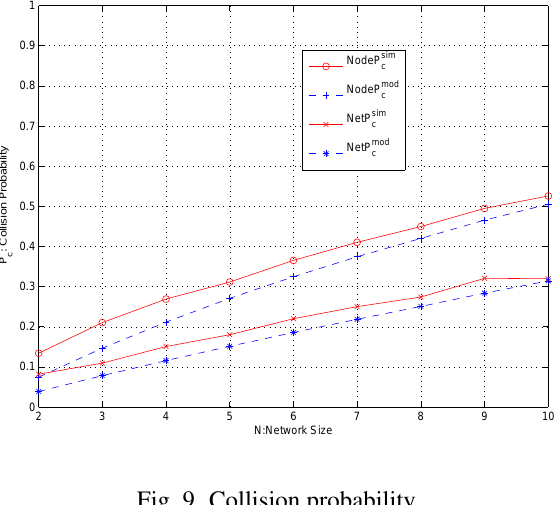
Fig. 9. Collision probability The power consumption is shown in Fig. 10. The simulation results well match the theoretic results. The interesting thing is that the average power con- sumption of the network is decreasing along with the number of nodes in the networks. There are notice- able differences in the average power consumption when the size of networks are small, say 2 or 3